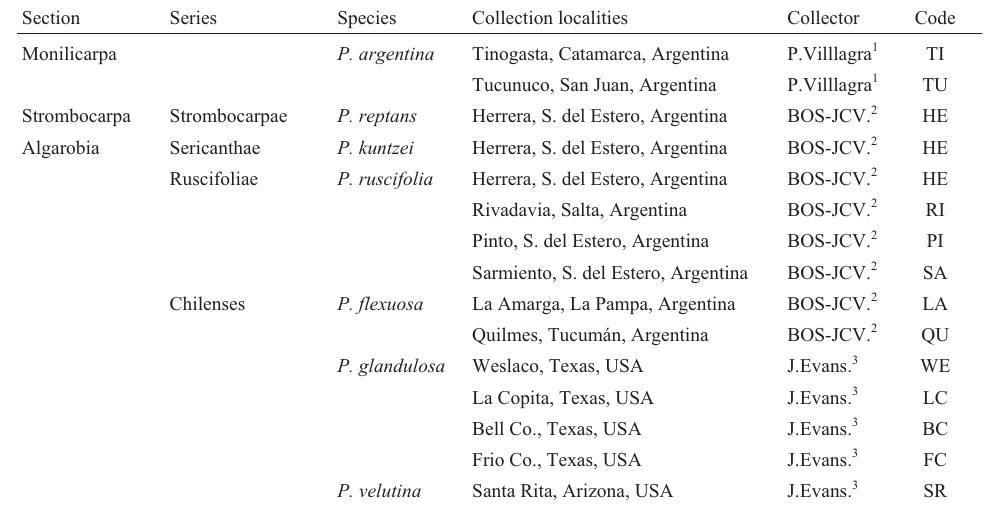
Table 1 - List of the sections, series, Prosopis species and populations studied, collectors and codes used to identify populations in Figure 1. Section